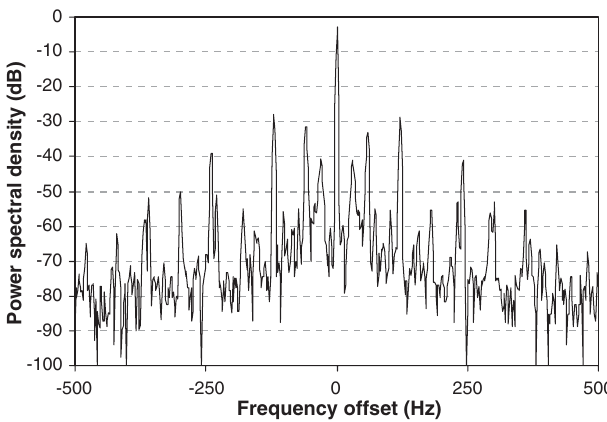
FIG. 5. Cavity spectral output (dB) with injection locked mag- netron and without DSP control, RBW ¼ 3 Hz .